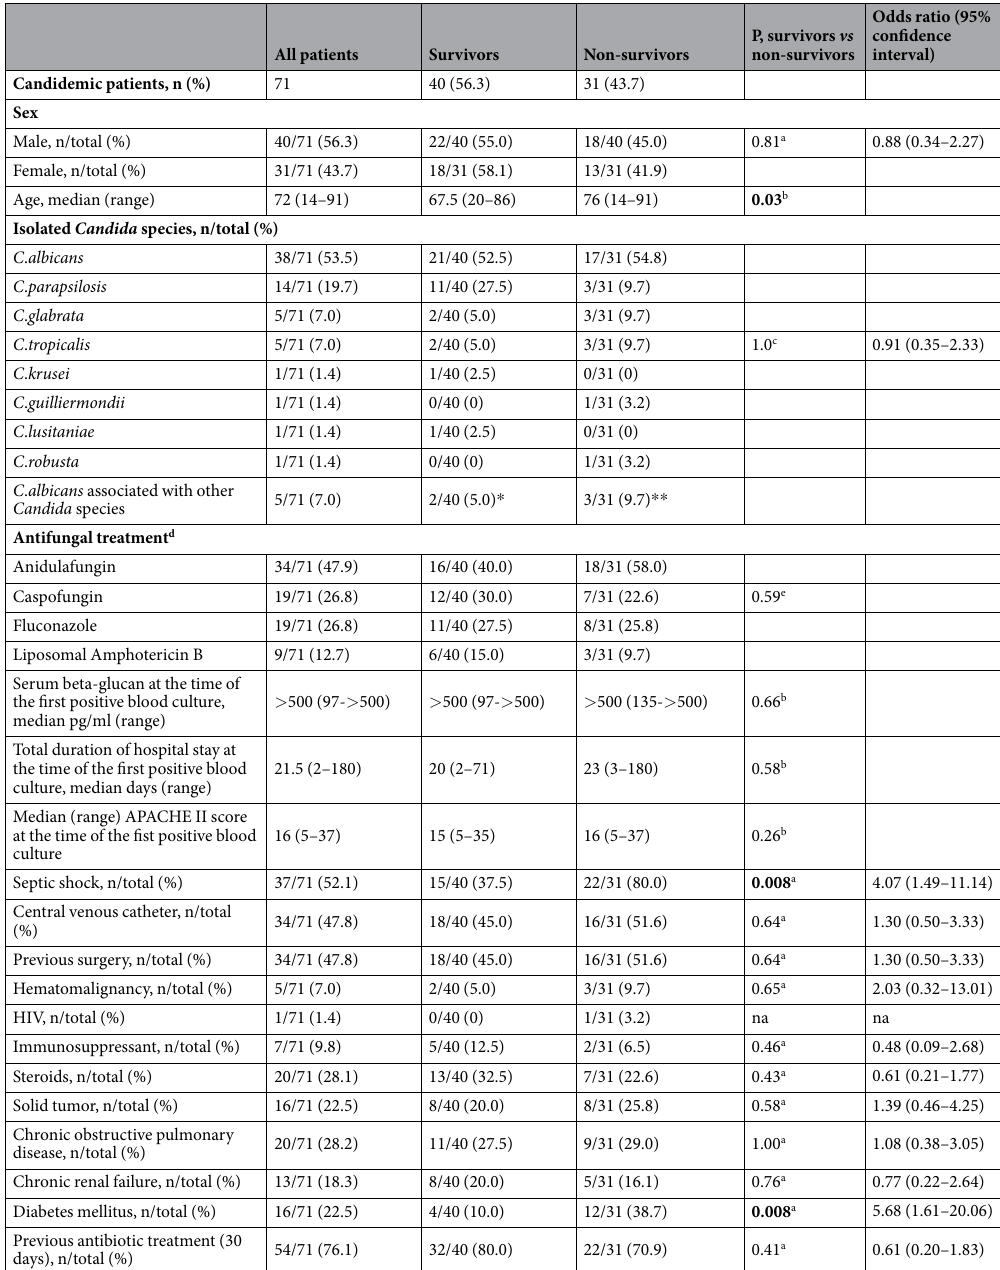
Table 1. Demographic, clinical and microbiological data of candidemic patients considered in the study. a Fisher exact test; b Mann-Whitney U test; * C . albicans + C . krusei (1), C . albicans + C . guilliermondii (1); ** C . albicans + C. glabrata c Fisher exact test evaluating isolation of non-albicans species, alone or in association, vs the isolation of C . albicans only d Nine patients were treated with more than one antifungal e Chi-square test na = not